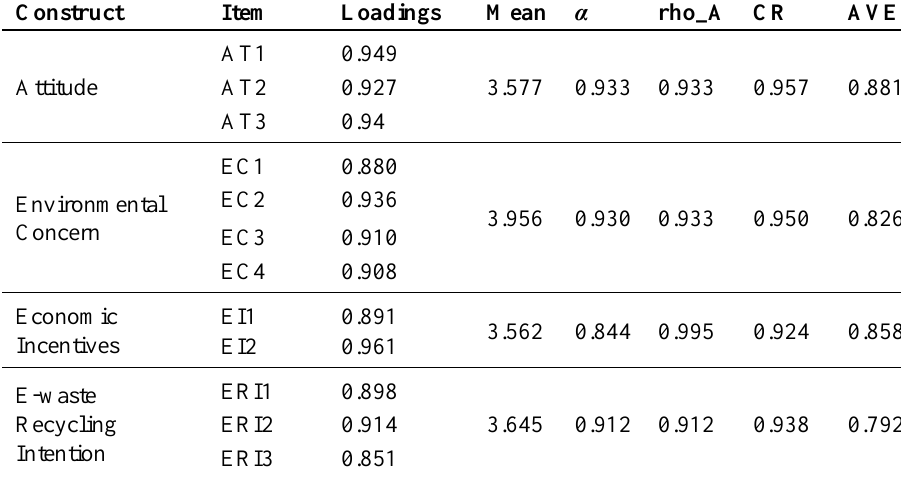
Table 1: Descriptive Statistics, Validity and Reliability Construct